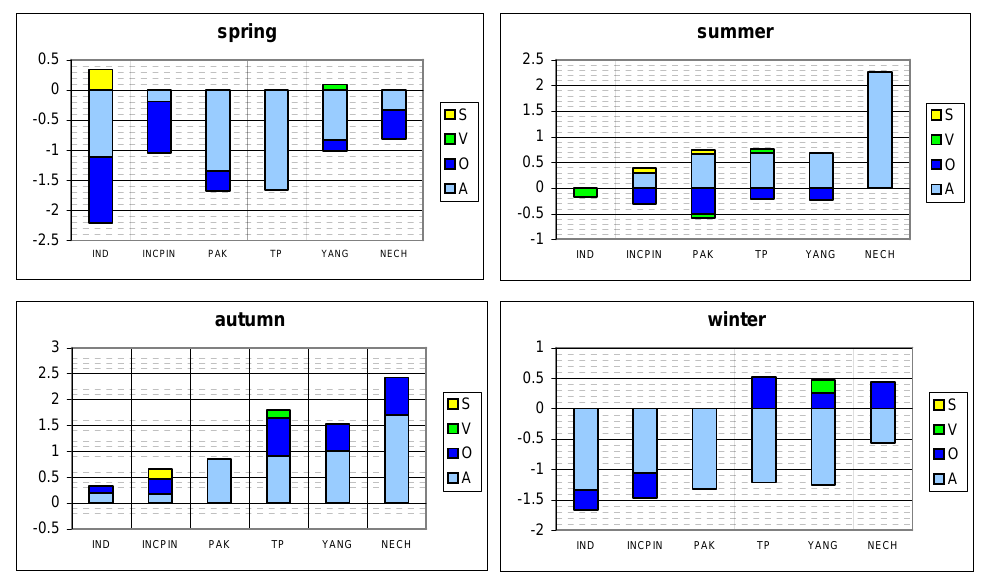
Fig. 5. Factors contributing to the seasonal temperature change between mid-Holocene (6k) and present-day (0k) climate for six regions in the area of the Asian monsoon. Only robust contributions are shown. Seasons are defined on astronomical calendar, based on the time of vernal and autumnal equinox as well as summer and winter solstice. Light blue colours show the results of the atmosphere-only run, i.e. the direct response of atmospheric dynamics (A) to changes in insolation. Dark blue colours represent the contribution of ocean-atmosphere-interaction (O), including sea-ice dynamics. Green colours indicate the contribution of vegetation-atmosphere interaction (V). Yellow colours reveal the contribution of the synergy (S) between atmosphere – ocean and atmosphere – vegetation feedbacks. Please note the change in